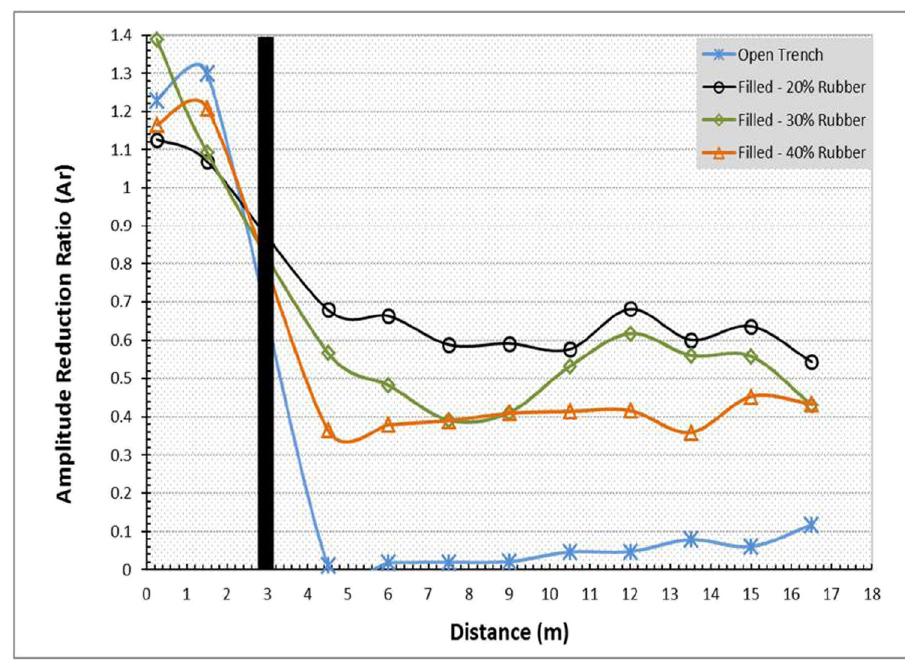
Figure 17: Attenuation of vibration due to active trench barriers ( f 70 Hz = ) .